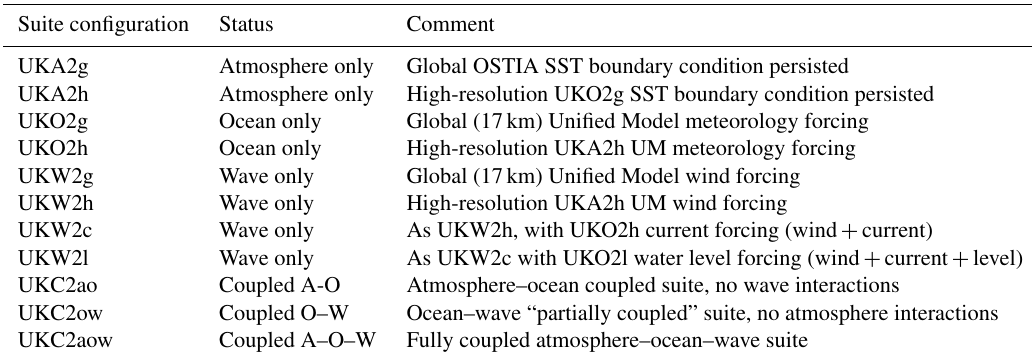
Table 2. Summary of UKC2 system coupled and uncoupled evaluation suites. Suite